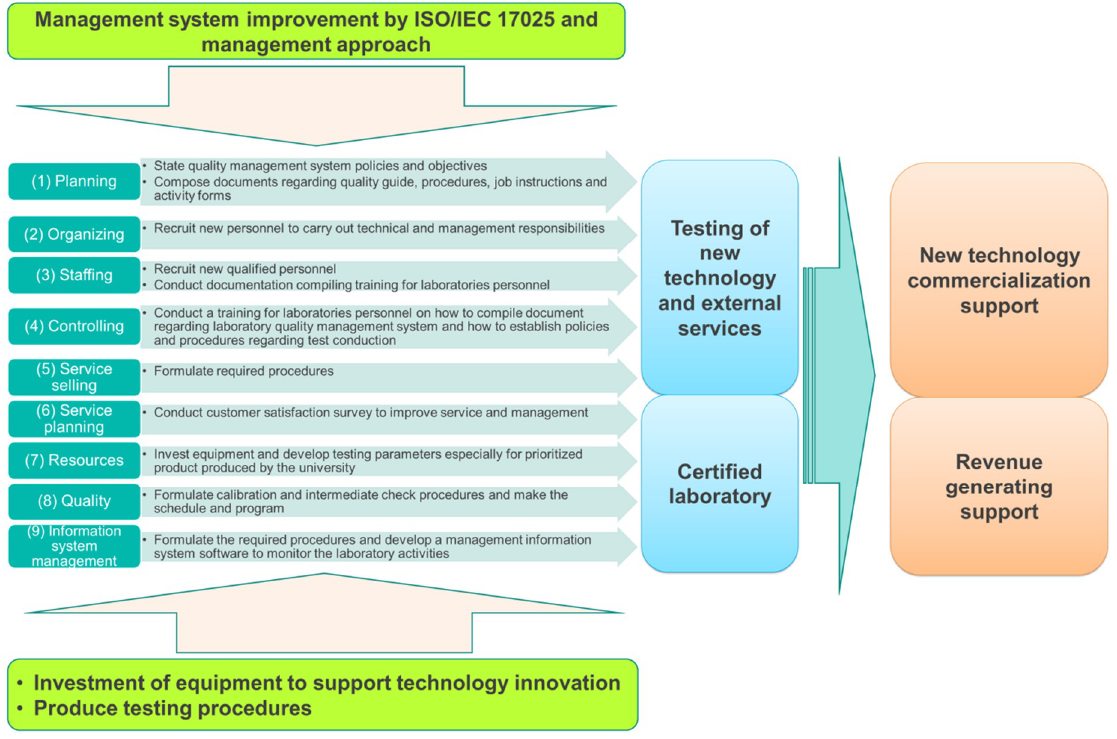
Figure 6. Summary of research implications.